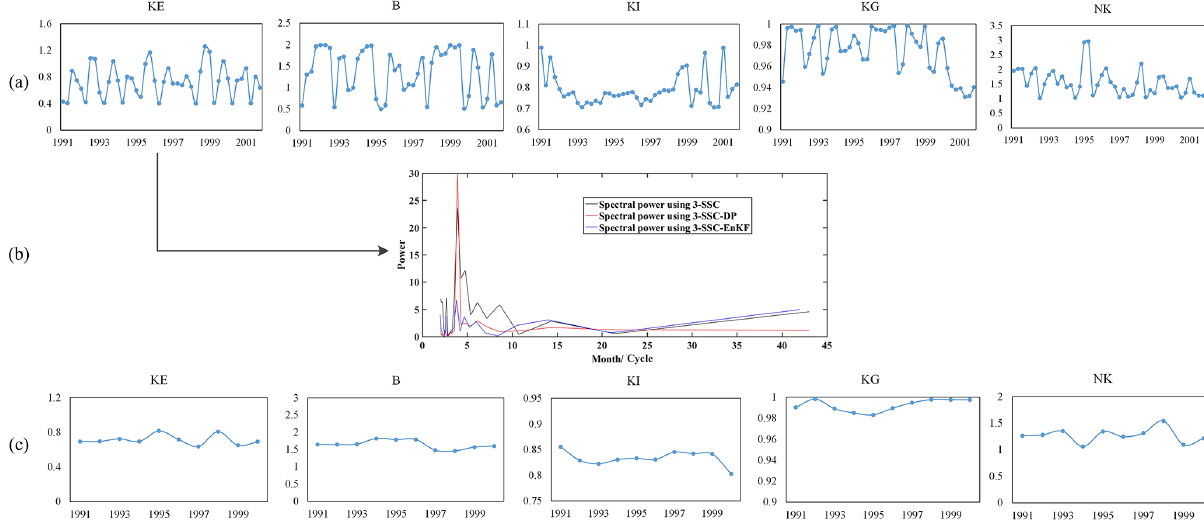
Figure 17. Estimated sensitive parameters of the Xinanjiang model for the Xun River basin over (a) a seasonal timescale and (c) an annual timescale. Plot (b) illustrates the spectral power of parameter KE using different